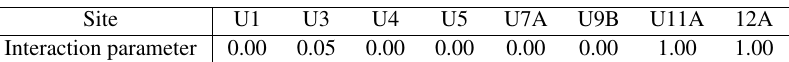
Table 9. Interaction Parameter of Model 4 at Different